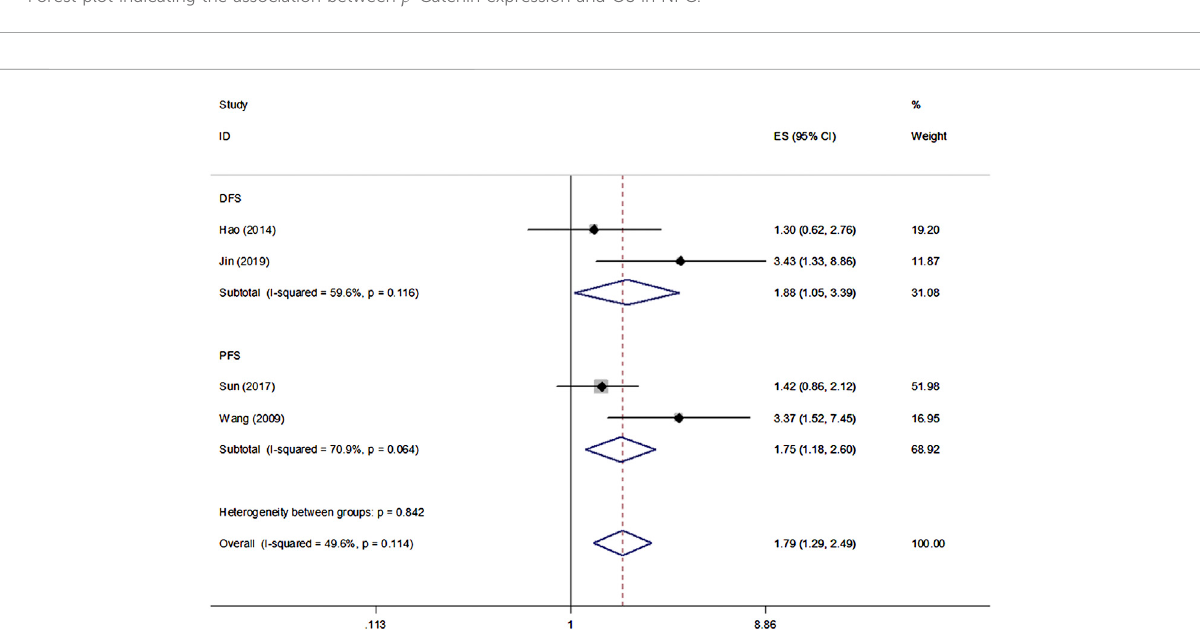
FIGURE 3 Forest plot examining the association between β -Catenin expression and DFS/PFS in